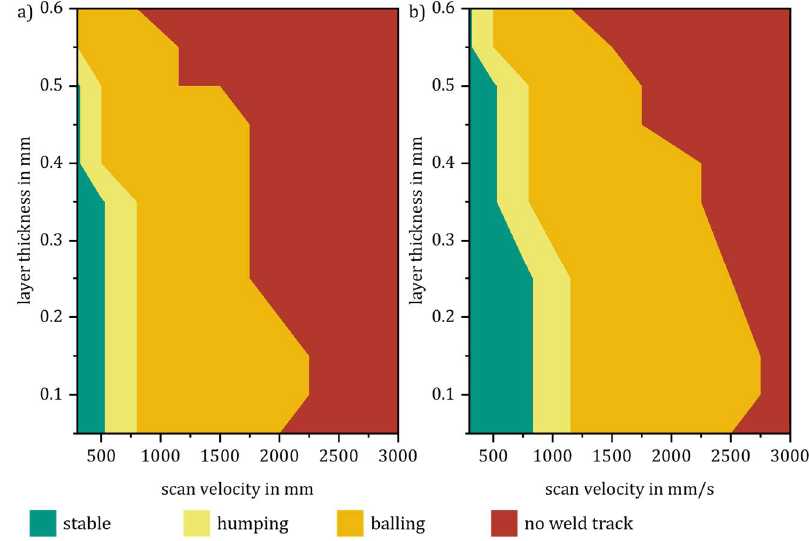
Figure 6. Weld track categories vs. scan velocity, layer thickness, and laser power: ( a ) P L = const. 300 W, ( b ) P L = const. 385 W.